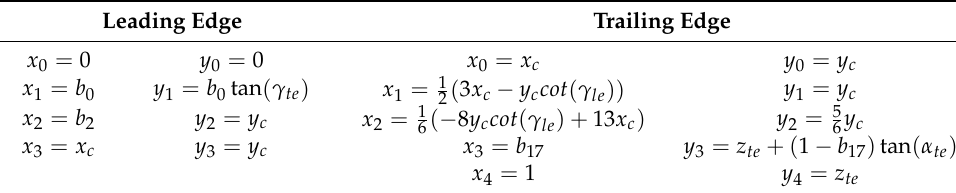
Table 3. Camber profile curve control points definition.